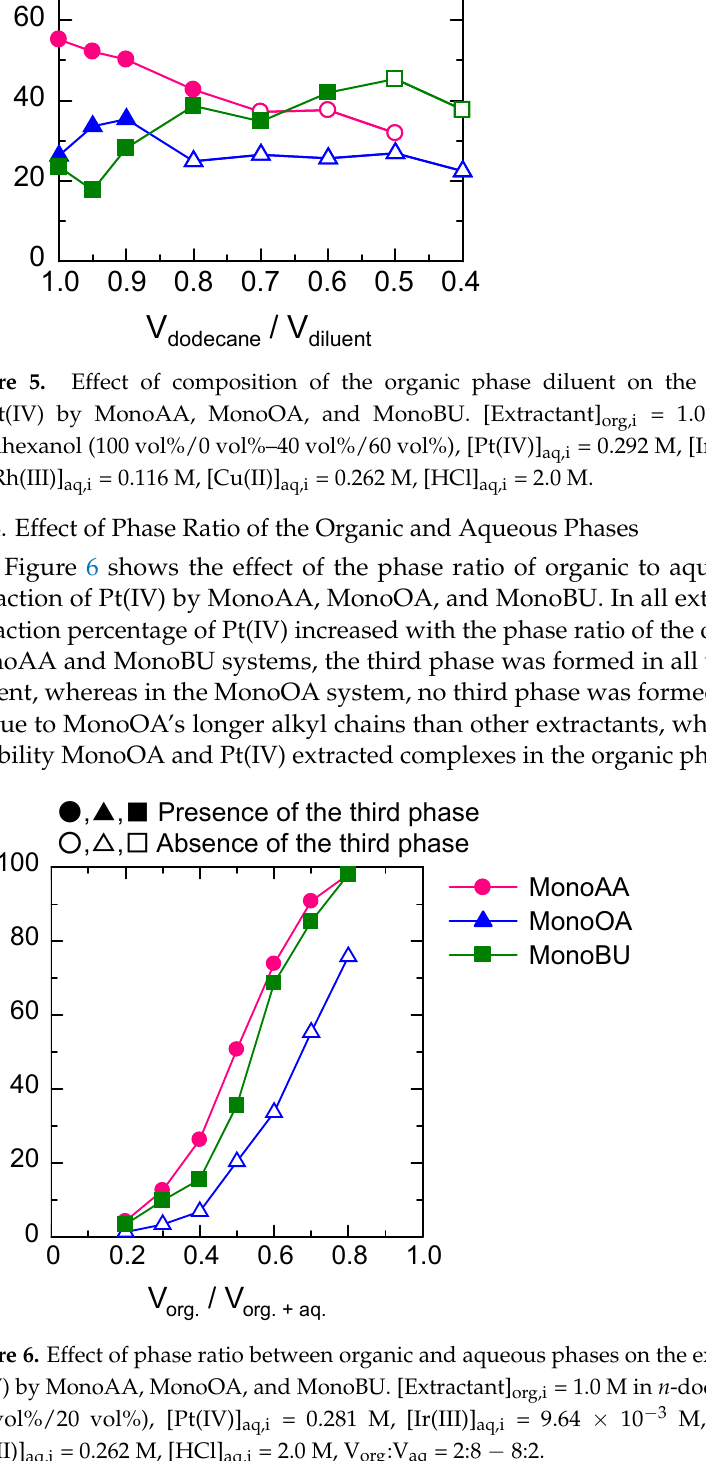
Figure 6. Effect of phase ratio between organic and aqueous phases on the extraction percentage of Pt(IV) by MonoAA, MonoOA, and MonoBU. [Extractant] org,i = 1.0 M in n -dodecane/2-ethylhexanol (80 vol%/20 vol%), [Pt(IV)] aq,i = 0.281 M, [Ir(III)] aq,i = 9.64 × 10 − 3 M, [Rh(III)] aq,i = 0.116 M, [Cu(II)] aq,i = 0.262 M, [HCl] aq,i = 2.0 M, V org :V aq = 2:8 − 8:2.